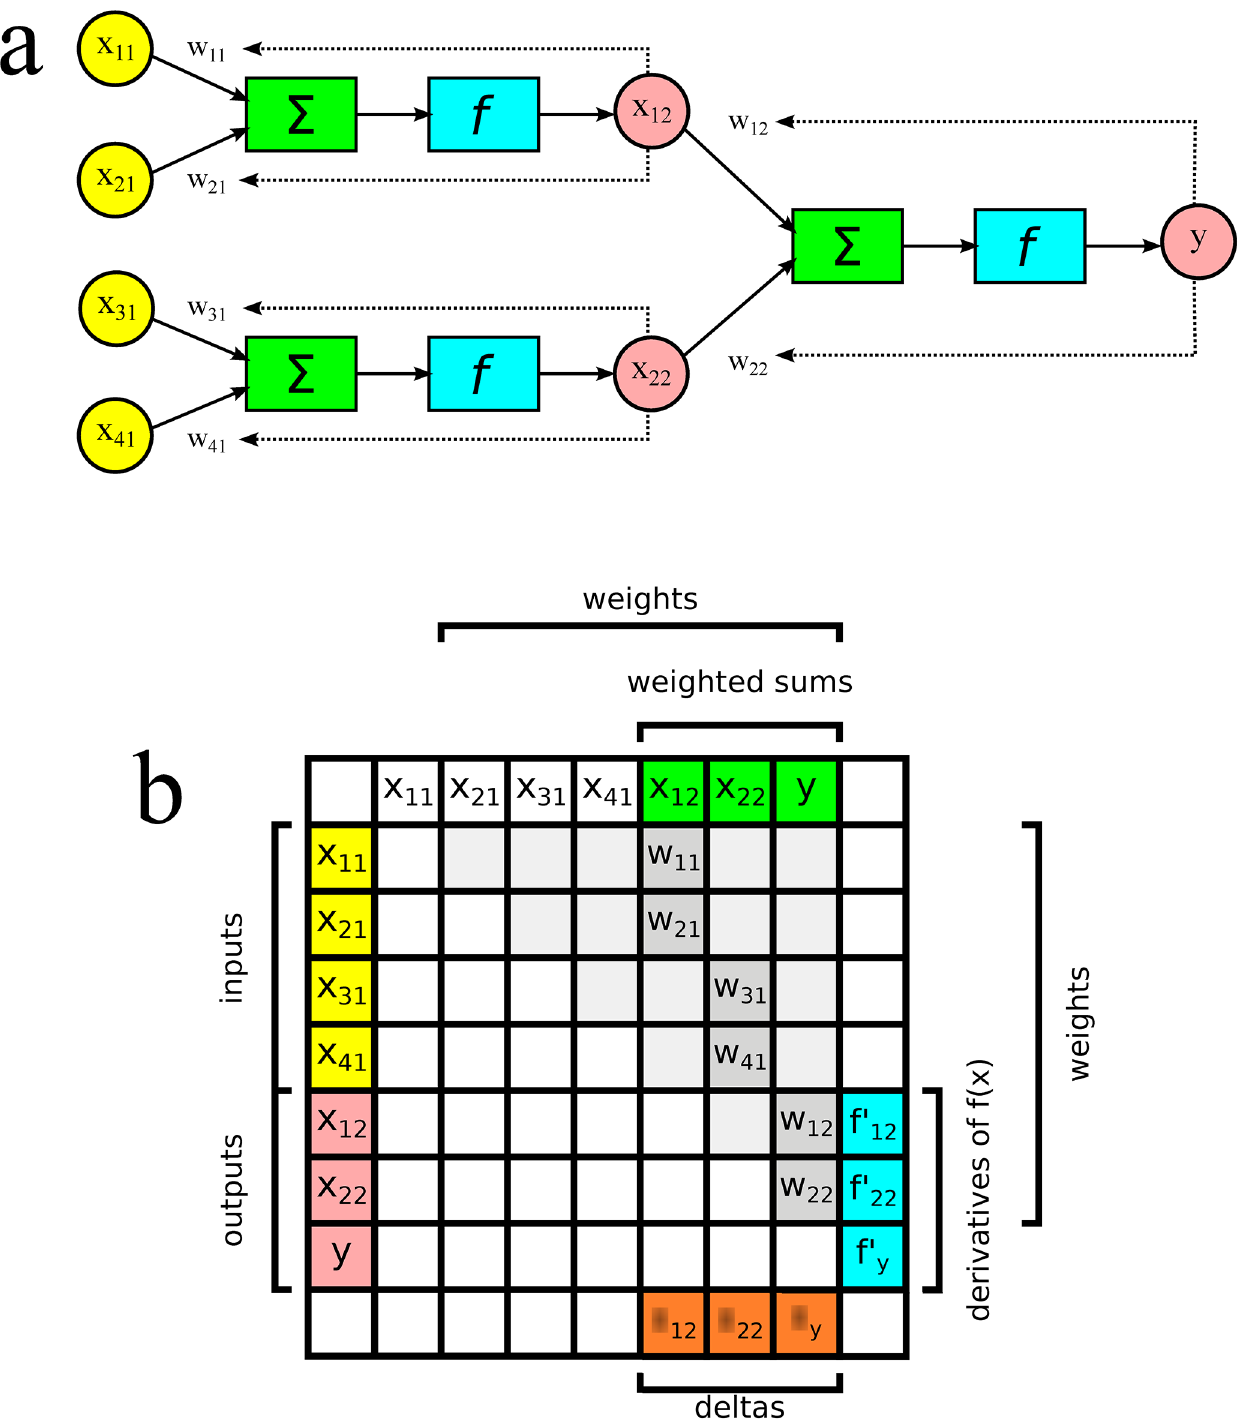
Fig 1. Artificial neural network and its learning matrix. a) Two-layer perceptron based on Rosenblatt [21] and Nazzal et al. [22]. b) Learning matrix elements.